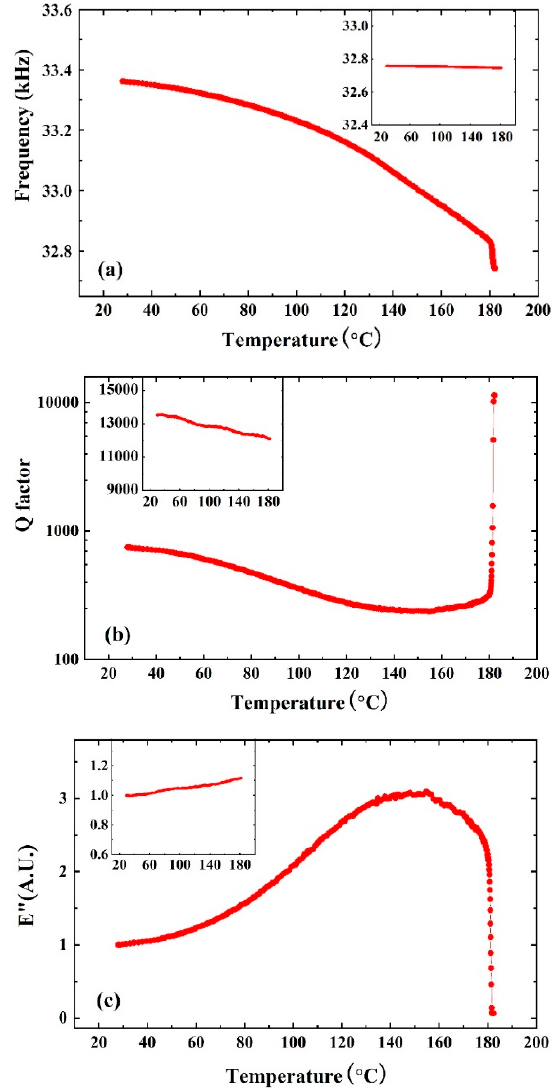
Figure 4. ( a ) The resonance frequency, ( b ) Q factor, and ( c ) loss modulus variations of PMMA MM-QTF as a function of temperature. The figure insets show the parameter variation of QTF without modification.